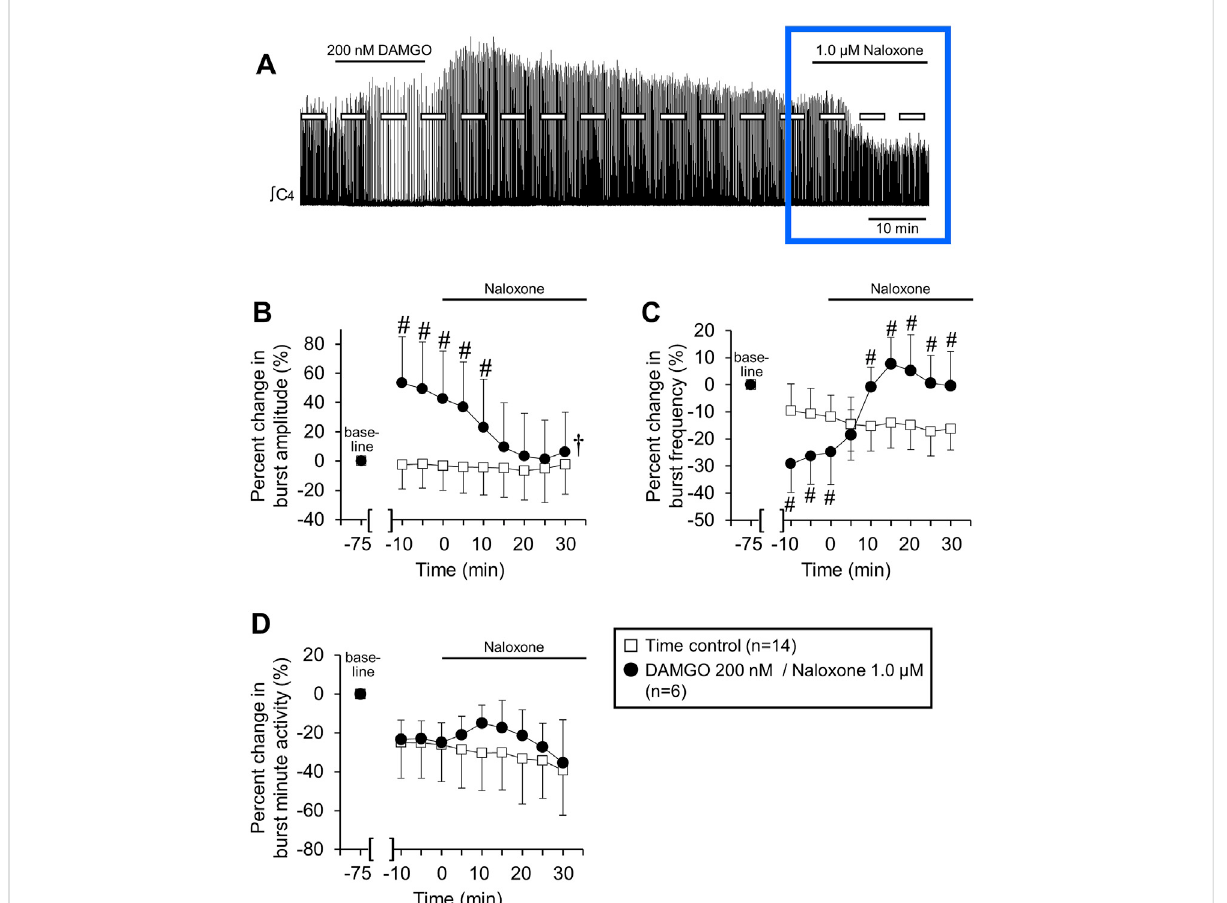
FIGURE 4 NaloxonereversedpersistentDAMGO-inducedeffectsoninspiratoryburstamplitudeandfrequency.Six/10brainstemspinalcordpreparations exposed to 200 nM DAMGO (15 min) had a persistent increase in burst amplitude after 60 min of washout. Naloxone (1.0 µM) was bath-applied to test whether DAMGO effects could be reversed. (A) Compressed voltage trace showing baseline (left) and DAMGO-induced changes in burst amplitudeandfrequencythatrapidlyreturnedtobaselinewithnaloxoneapplication.Theblueboxhighlightsthepartofvoltagetracesthatwere analyzed for the graphs below. (B) Naloxone application rapidly returned increased burst amplitude to time control levels. (C) Naloxone application rapidly increased burstfrequencyabove timecontrollevels. (D) Minuteactivitywas notaltered bynaloxoneapplication.The pound sign(#)indicates a signi fi cant pairwise comparison difference from time controls at that time point, and the dagger ( † ) indicates a signi fi cant overall DAMGO concentration effect. Data shown as mean ± SD. These data indicate that the persistent DAMGO-induced inspiratory motor burst increase was not likely due to